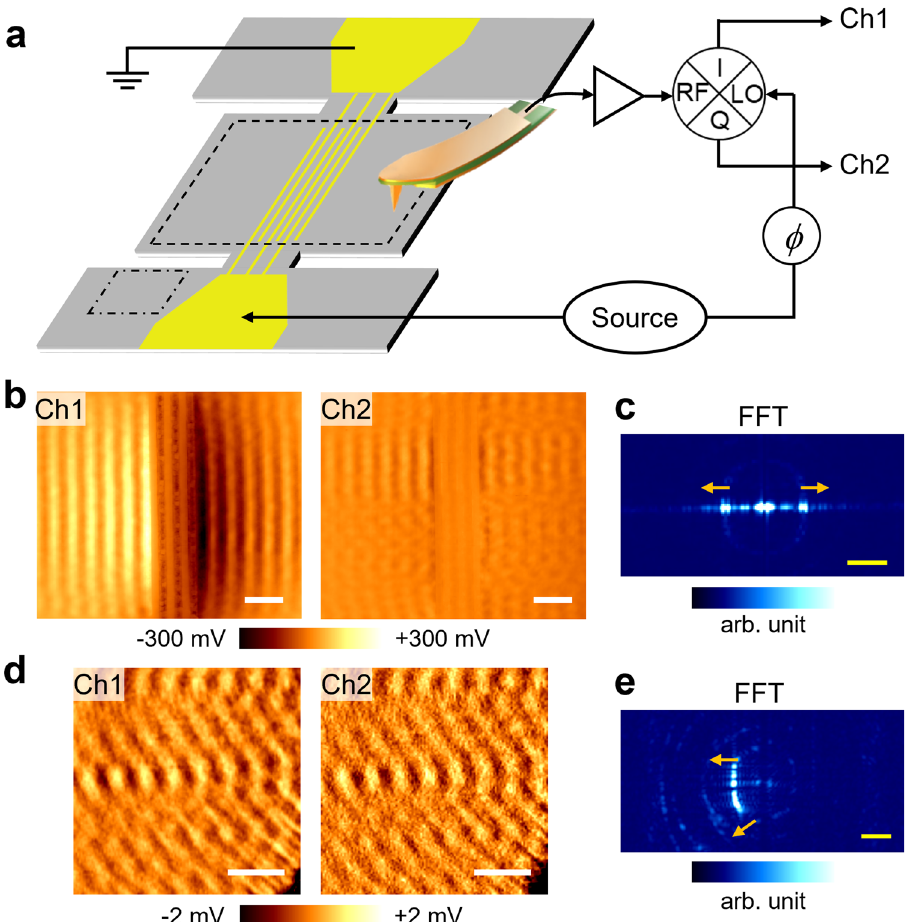
e Corresponding FFT image of ( d ). The arrows in ( c ) and ( e ) indicate the wave propagationdirectionin k -spacemaps.Scalebarsin(b)and(d)are5 μ m.Scalebars in ( c ) and ( e ) are 0.4 μ m − 1